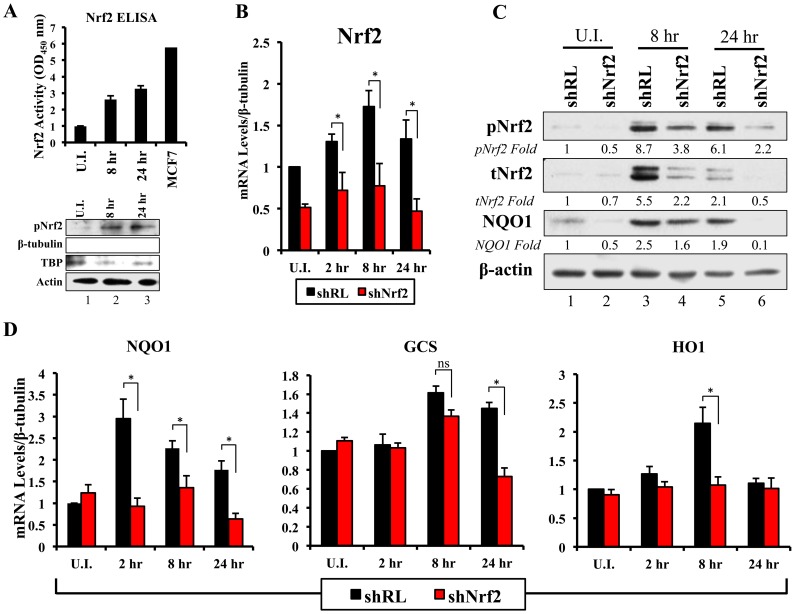
Lentiviral knockdown of Nrf2 and the effects on target genes during KSHV infection.
A) Top: Nrf2 ELISA was used to quantify the DNA (ARE)-binding affinity of Nrf2 during KSHV infection (20 DNA copies/cell). Nuclear proteins from infected and uninfected cells were quantified using a BCA assay, and equal amounts of protein (15 µg) were assayed using the TransAM Nrf2 ELISA Kit. The OD450, measuring the binding of Nrf2, in the uninfected condition (U.I.) was arbitrarily set to 1, and the bars indicate mean fold induction ± SD for two independent replicates. 30 µg of MCF7 nuclear extract was used as a positive control for Nrf2 activity. Bottom: Western blot for pNrf2 in the nuclear fraction was performed for quality control. β-tubulin was used as a cytoplasmic control, TATA Binding protein (TBP) was used as a nuclear control, and β-actin was used as loading control. B) Real-time RT-PCR analysis assessing Nrf2 mRNA levels in HMVEC-d cells transduced with lentiviral vectors expressing short-hairpin RNA against Renilla luciferase (shRL – control) or against Nrf2 (shNrf2) for at least 24 hr. The uninfected (U.I.) shRL condition was arbitrarily set to 1 and the bars indicate mean fold induction ± SD for 4 independent experiments. C) Representative Western blot analysis assessing Nrf2 knockdown in HMVEC-d cells transduced with lentiviral vectors expressing shRL or shNrf2 for at least 24 hr, and infected with KSHV (20 DNA copies/cell) for the indicated time points. NQO1 induction was used to determine the activity of Nrf2 transcriptional activity during KSHV infection. β-actin was used as a loading control. D) Real-time RT-PCR analysis of Nrf2 target genes involved in ROS homeostasis. β-tubulin was used as an endogenous control, the U.I. shRL cells were arbitrarily set to 1, and the bars indicate mean fold induction ± SD for 4 independent experiments. * = p<0.05. (NQO1 = NAD(P)H quinone oxidase 1; GCS = Gamma-glutamylcysteine synthase; HO1 = Heme oxygenase 1).